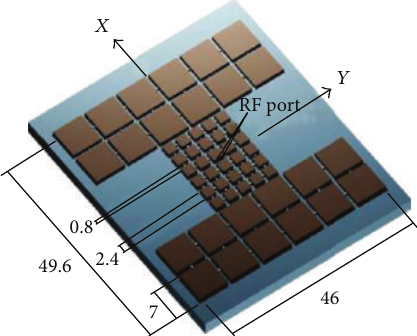
Figure 6: Multifunctional reconfigurable antenna (with permission from